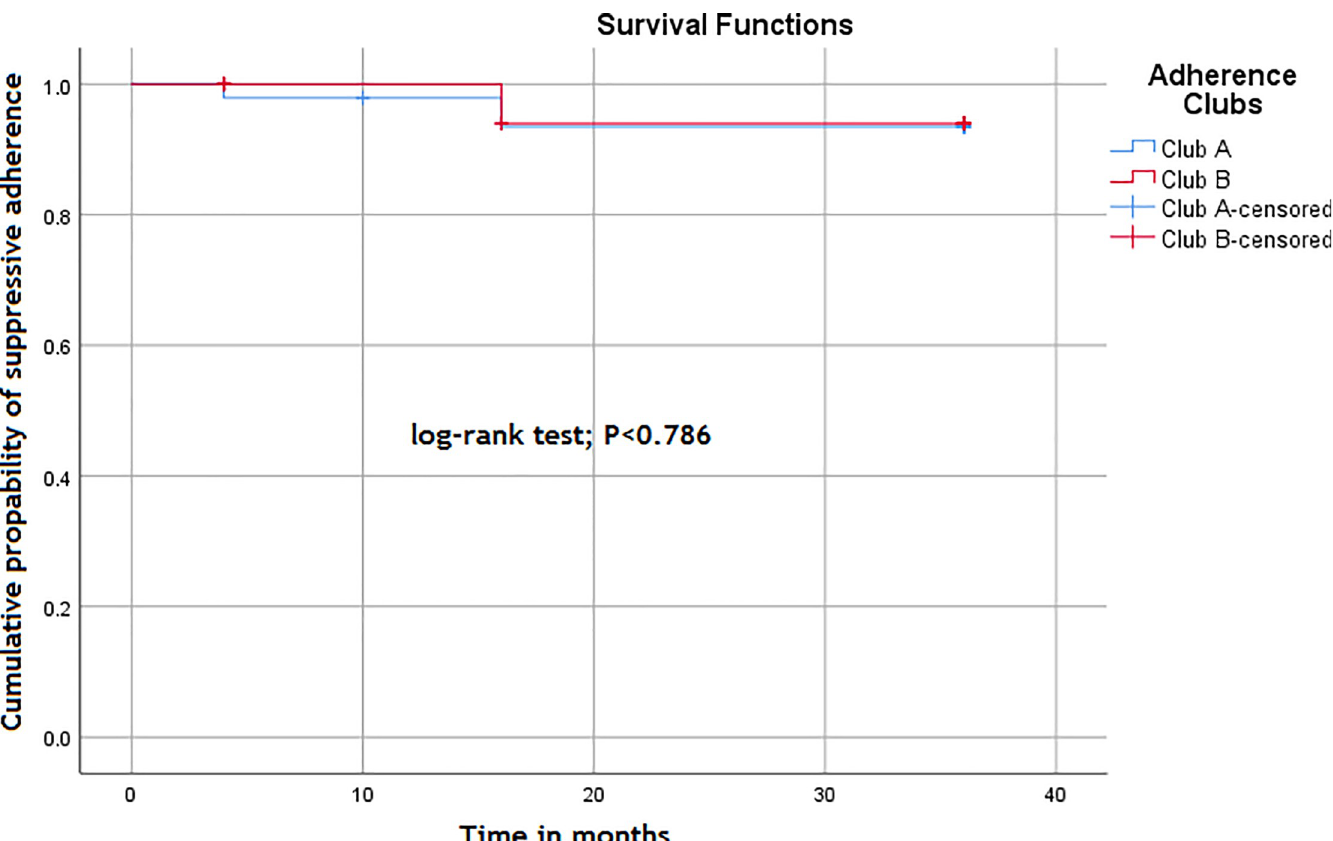
Fig 5. Survival distribution of suppressive adherence behaviour of two adherence clubs at Facility